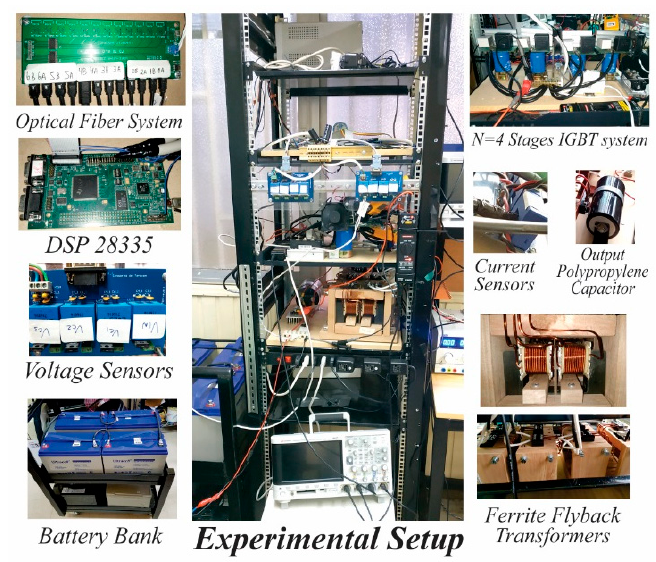
Figure 9. Experimental laboratory prototype.